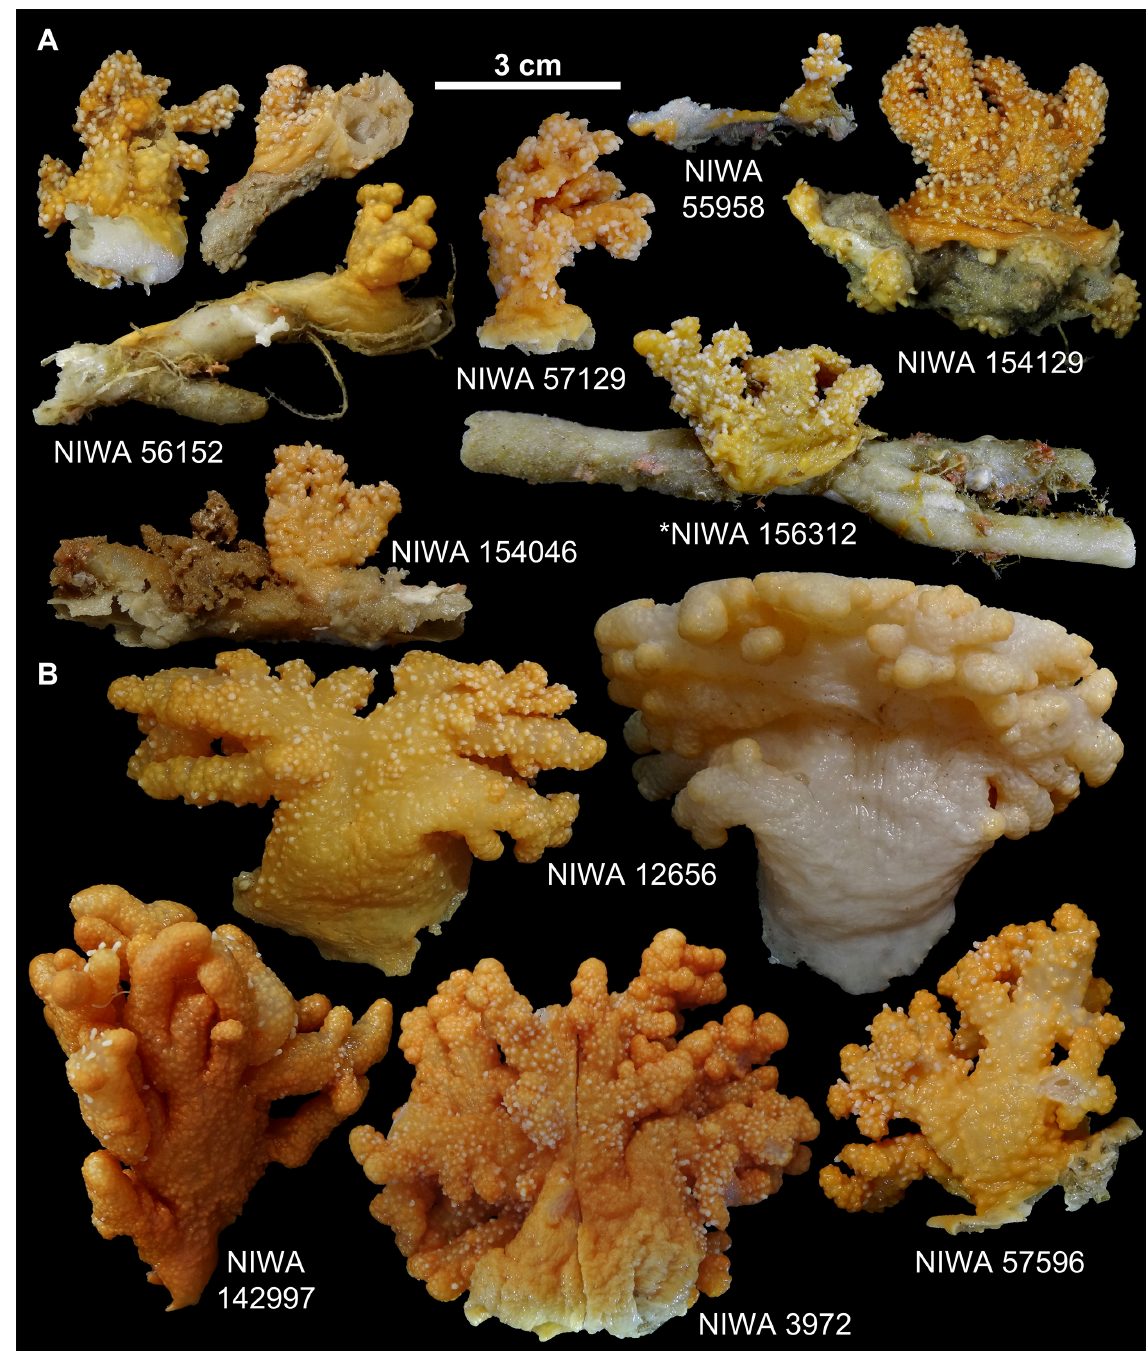
Fig. 7. Preserved specimens. A . Kotatea amicispongia gen. et sp. nov. B . K. aurantiaca gen. et comb. nov., expanded and stalked specimens. Note NIWA 154046 and NIWA 142997 contain additional fragments that are not depicted. * =